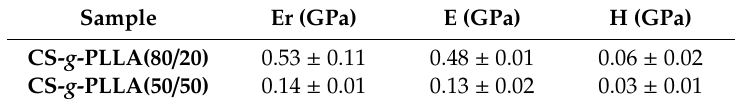
Table 2. Reduced modulus (Er), Young’s modulus (E) and hardness (H) values of the CS- g -PLLA copolymersat1000nmindentationdepthfollowing5sholdingtimeand10sloadingandunloadingtime.